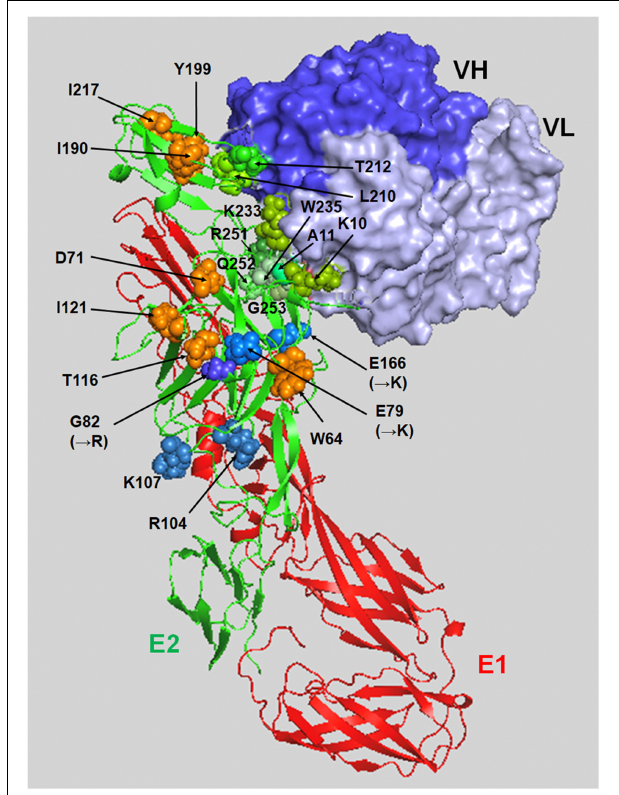
FIGURE 1 | A binding model of the E2-E1 heterodimer and NAb CHE19 on the CHIKV Thai#16856 spike. The binding of CHE19 Fab fragment (surface drawings, blue: the heavy chain, light blue: light chain) on the E2-E1 heterodimer (ribbon drawings reconstructed using PDB ID 3N42, red: the E1 glycoprotein, green: the E2 glycoprotein) is shown. The residues shown as green spheres (K10, A11, L210, T212, K233, W235, R251, Q252, and G253) are in contact within 4 Å of the heavy atoms of the NAb CHE19 paratope. The optimal binding sites of Mxra8-Fc are shown as orange spheres (W64, D71, T116, I121, I190, Y199, and I217). The residues shown as blue spheres are as follows; R104 and K107 in the predicted E2 amino acids for HS binding, and the residues substituted to the positively charged ones in 181/25 vaccine strain [G82( → R)] and mutant [E79( → K) and E166( → K)] in mutant CHIKV. Those positively charged residues are responsible for HS binding. This image was visualized using PyMOL